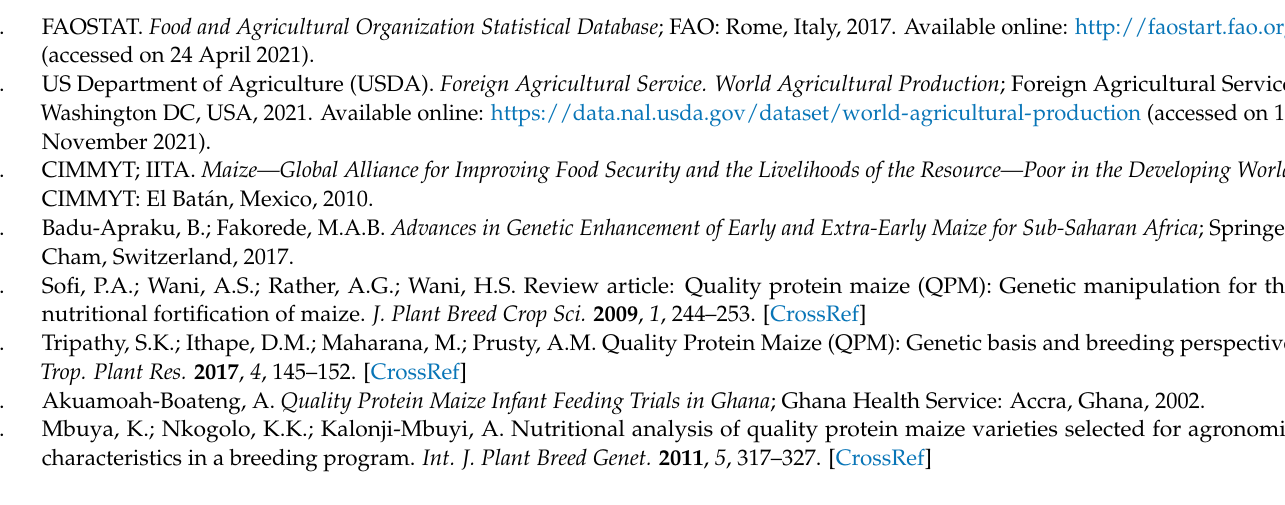
Table S1: North Carolina Design II mating design among 24 early quality protein maize inbred lines. Table S2: Daily minimum and maximum tempearture at Kadawa 2020 dry season. Table S3: Daily minimum and maximum tempearture at Kadawa 2021 dry